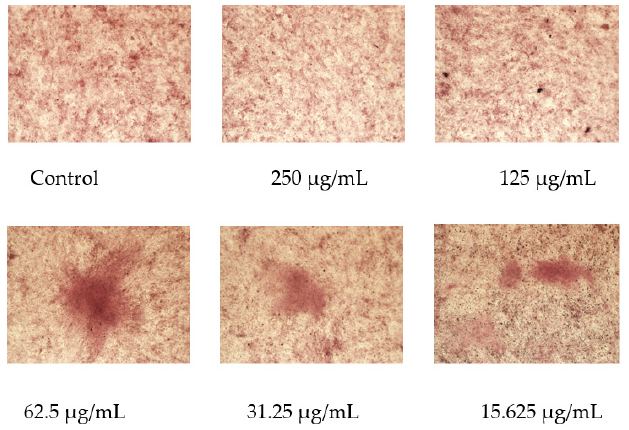
Figure 11. Effect of osmanthus fragrans extract on alizarin red staining of MC3T3-E1. Alizarin red staining was performed after MC3T3-E1 cells were treated with different concentrations of osmanthus fragrans extract for 21 days. The mineralized nodule was observed under the microscope (×10).